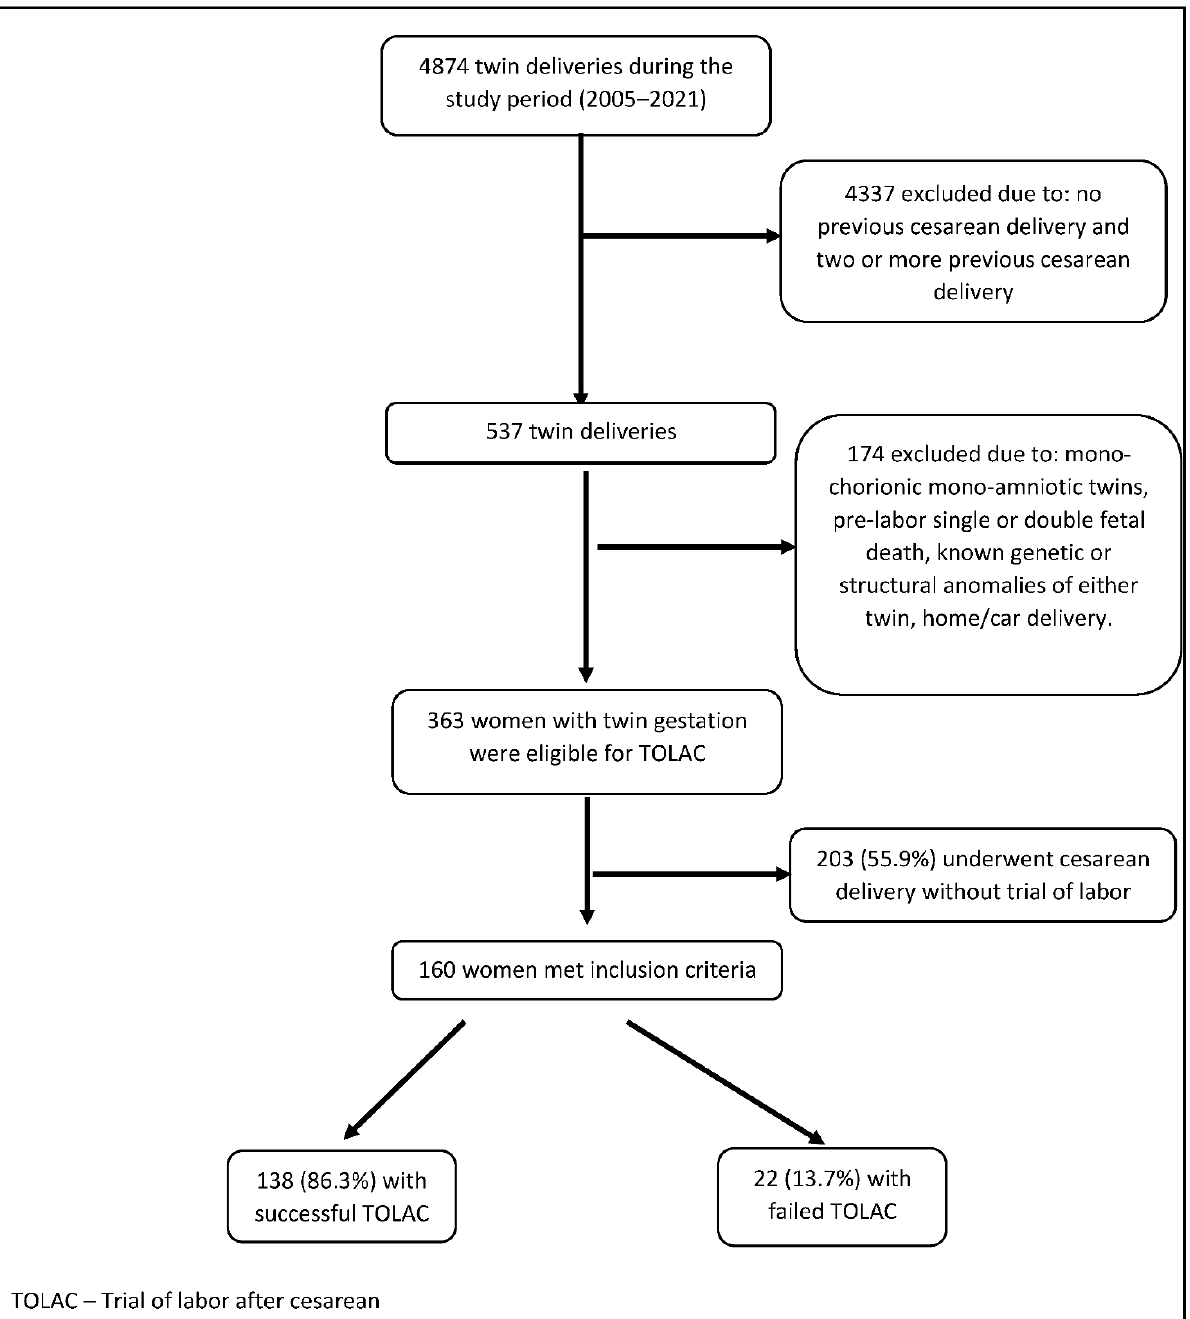
Figure 1. Study flow chart.